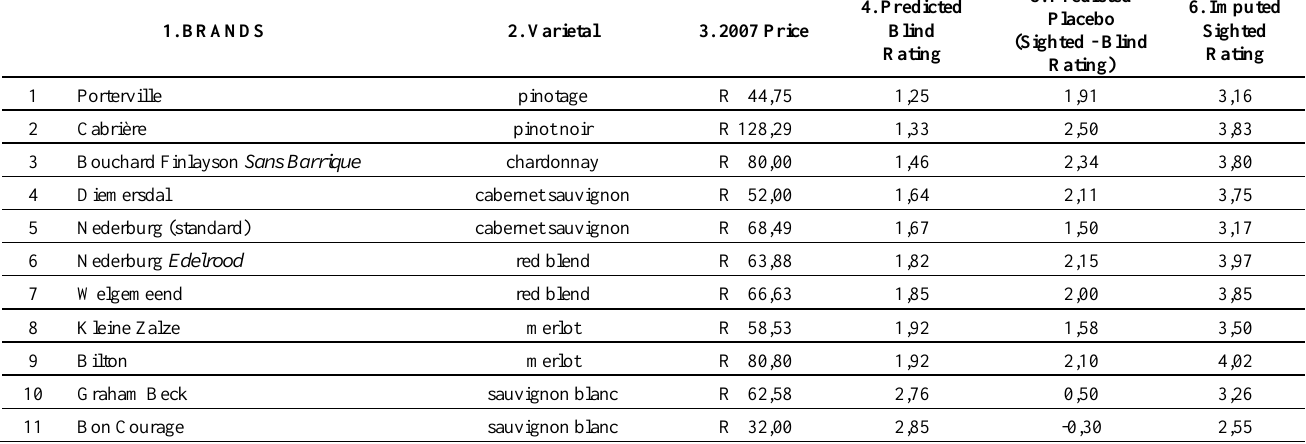
Table 2: The 35 selected brands that qualify simultaneously with functional and symbolic/placebo effects. These effects are ranked by ascending order of their predicted average blind score (column 4). In turn, this fitted value is added to column 5’s predicted average placebo ( sighted-minus blind ) score (also fitted); thus imputing the sighted score (col. 6). Both fitted values are derived from the brand-identification models featured in Priilaid and Van Rensburg